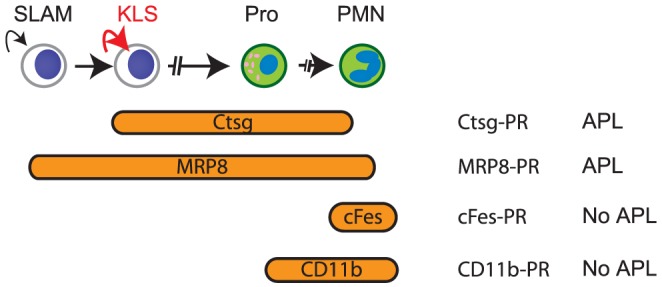
Model of APL development in Ctsg-PML-RARA mice.Murine APL requires the expression of PML-RARA in a multipotent progenitor, and cooperation of PML-RARA with myeloid restricted elements; expression of PML-RARA within promyelocytes is insufficient to cause leukemia. Orange ellipses indicate compartments with expression of the indicated genes used to direct expression in transgenic models. Red arrows indicate inappropriate self-renewal resulting from Ctsg-PML-RARA expression. Broken arrows indicate that multiple differentiation steps exist between indicated compartments. SLAM: lineage negative/Kit+/Sca-1+/CD150+/CD41−/CD48−. KLS: c-Kit+/lineage negative/Sca-1+. Pro: promyelocyte. PMN: polymorphic neutrophil. Concept after Lane and Ley [28].